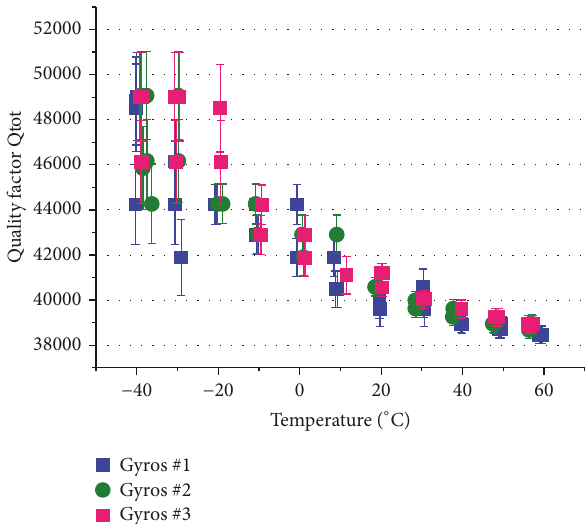
versus temperature. tot